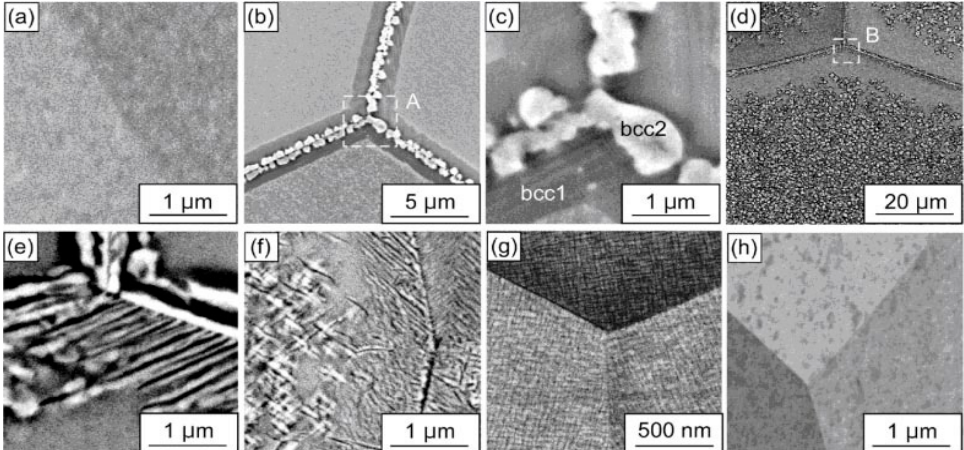
Figure 7. BSE images of the HfNbTaTiZr polycrystals annealed at 673–1173 K for 24 h. ( a ) 1173 K, ( b , c ) 1073 K, ( d , e ) 973 K, ( f ) 873 K, ( g ) 773 K and ( h ) 673 K. ( c , e ) are enlarged views of regions A and B in ( b , d ), respectively. Reprinted with permission from Ref. [5]. Copyright 2021 Elsevier.